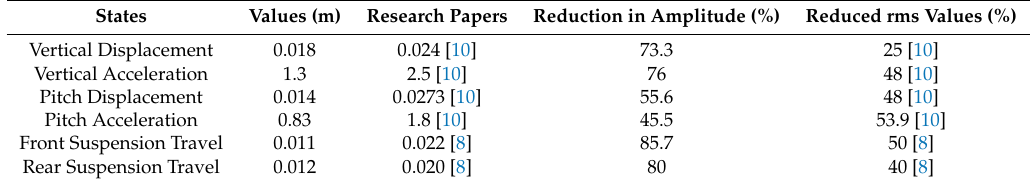
Table 2. RMS values comparison with previous